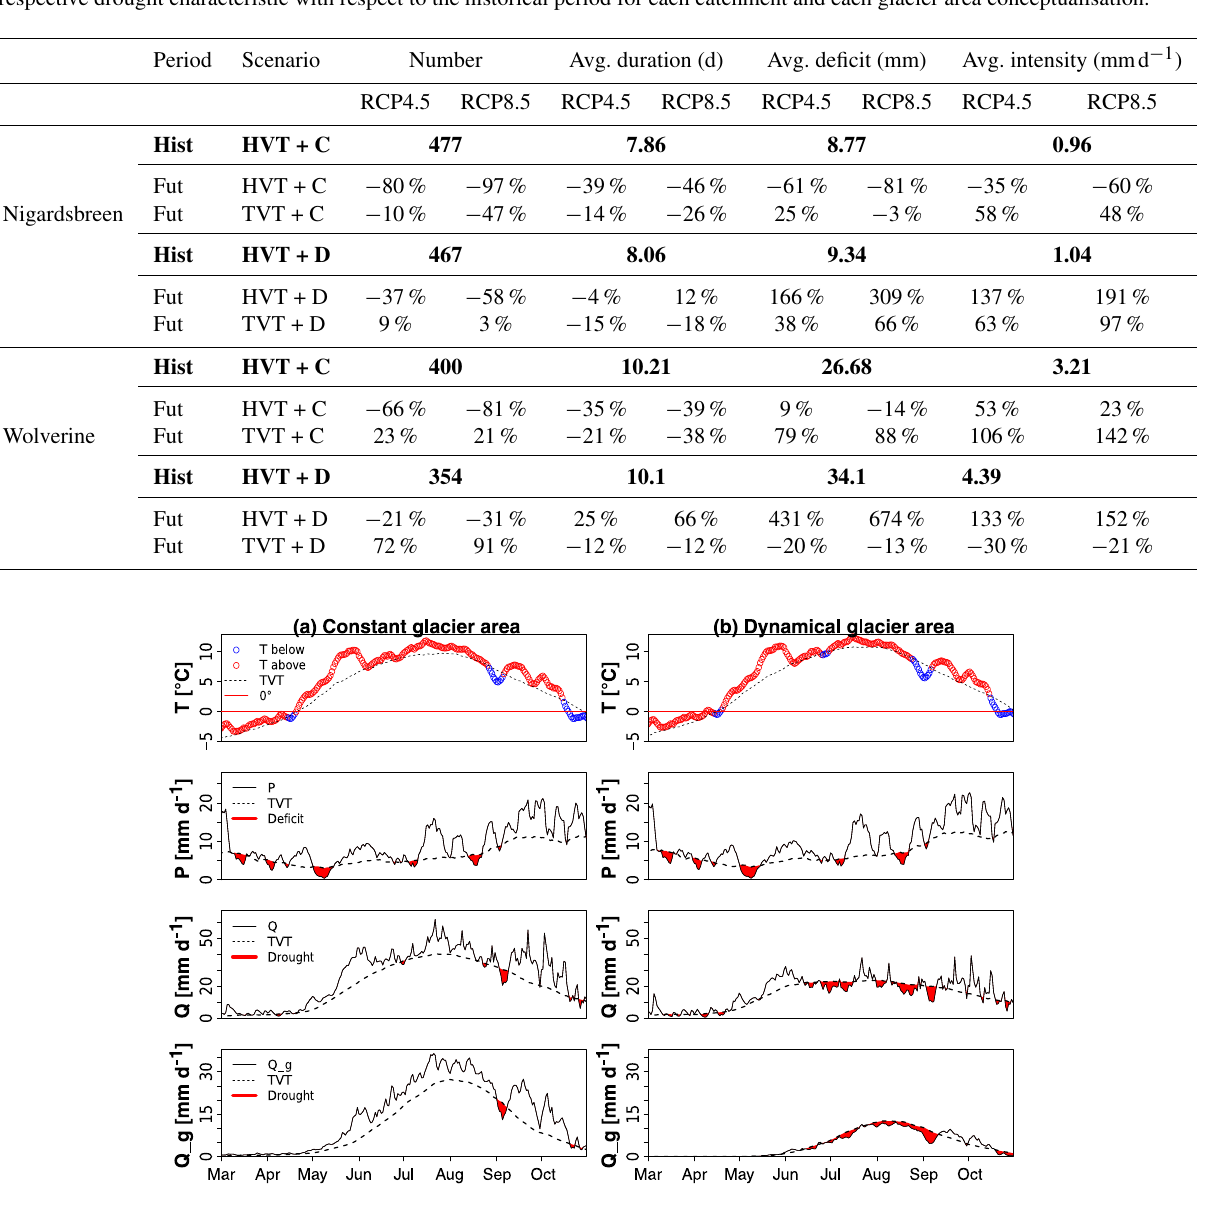
Table 3. Change in drought characteristics in the future compared to the historical period. The percentages show the increase or decrease of the respective drought characteristic with respect to the historical period for each catchment and each glacier area conceptualisation.